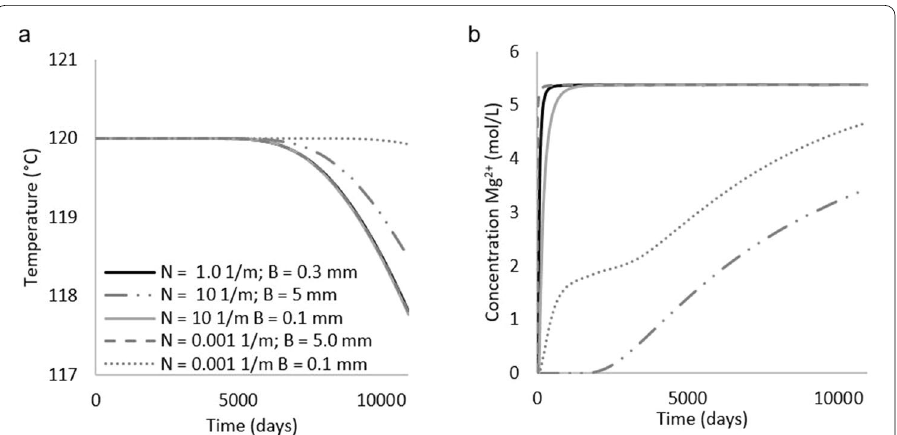
Fig. 7 Comparison of sensitivity to fracture frequency (N) and aperture (B) for a observed temperature at the production well and b Mg 2 + at the production well in a geothermal doublet system